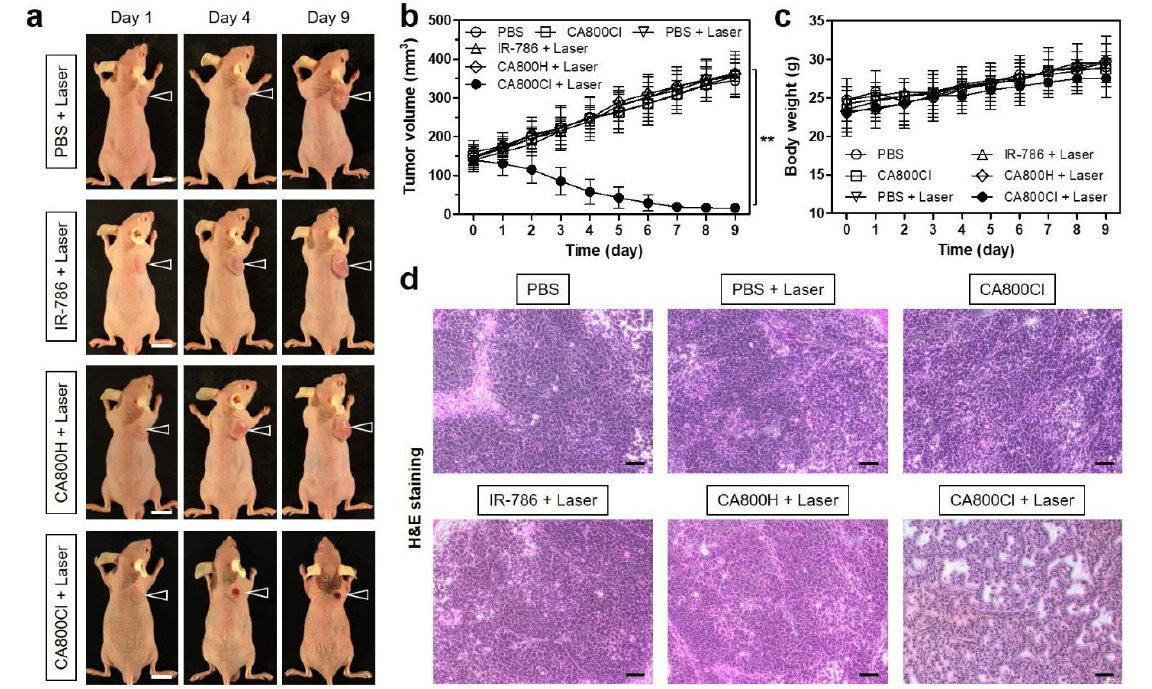
Figure 6. In vivo phototherapeutic efficacy of CA800Cl NIR fluorophore. ( a ) Representative photos of changes in tumor size in NCI-H460 tumor-bearing mice for 9 days after different treatments. The laser groups were treated with 24 h post-injections of PBS, IR-786, CA800H, and CA800Cl, followed by 808 nm laser irradiation (1.1 W/cm 2 ) for 5 min. Scale bars = 1 cm. ( b ) Tumor growth rates and ( c ) body weights of each treatment group were monitored for 9 days. Data are expressed as mean ± S.D. (n = 3). ** p < 0.01. ( d ) Tumor sections stained with H&E from each group 24 h after different treatments. Scale bars = 100 μm.